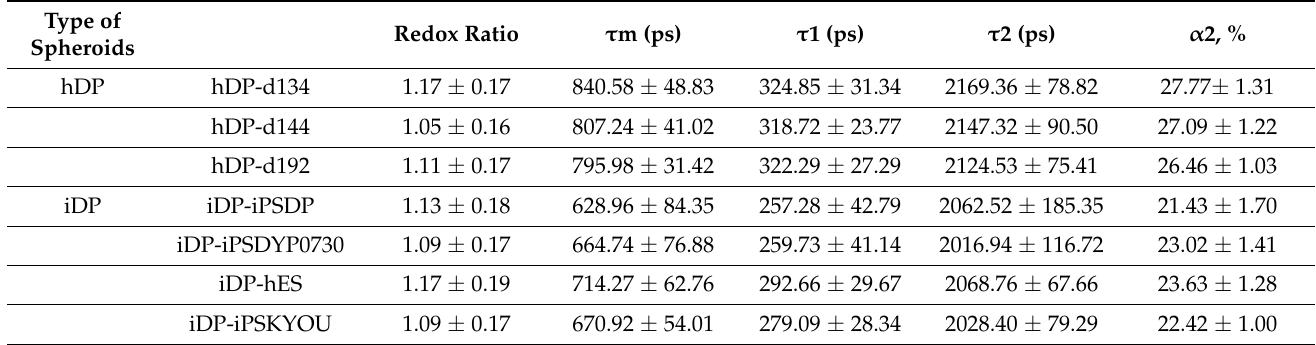
Table 3. Data on the redox ratio and FLIM parameters in hDP and iDP spheroids (mean ± SD). Type of